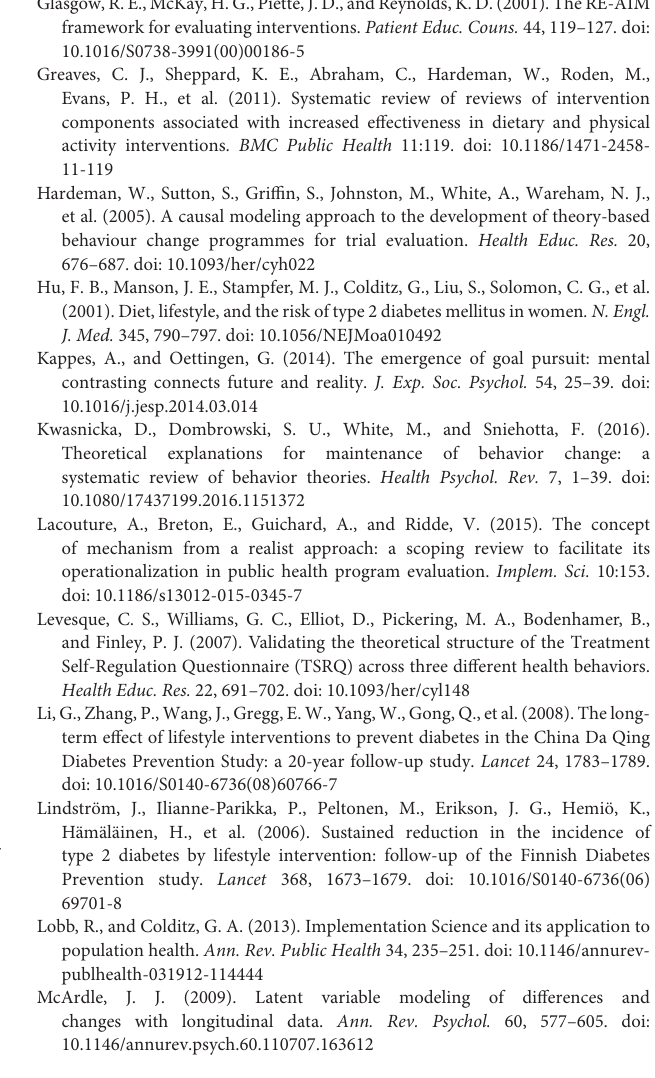
Supplementary Table 1 | Overview of behavior change stages, objectives, behavioral mechanisms/predictors, behavior change techniques and tools, as well as